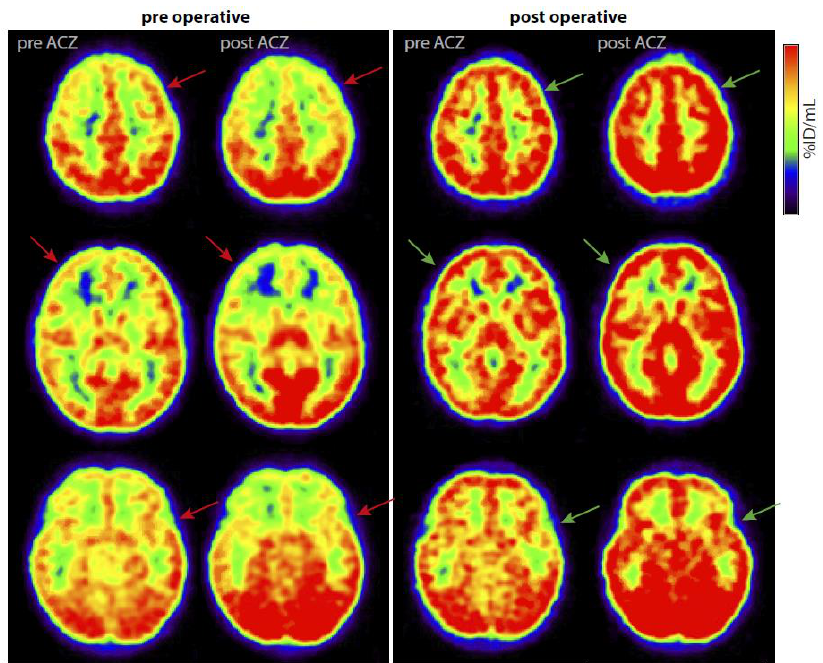
Figure 3. Example of improvement of cerebrovascular reactivity (CVR) on [ 15 O]H 2 O-PET in an 11-year-old girl with moyamoya syndrome. The left two columns are pre-operative and before and after acetazolamide (ACZ) challenge. The red arrows show examples of vascular steal. She was first operated with a right-sided combined direct/indirect bypass with additionally a bifrontal EDAMS, followed by a left-sided indirect bypass during a second surgery. The right two columns show the same patient approximately at follow-up. The green arrows show the same areas with improved CVR.